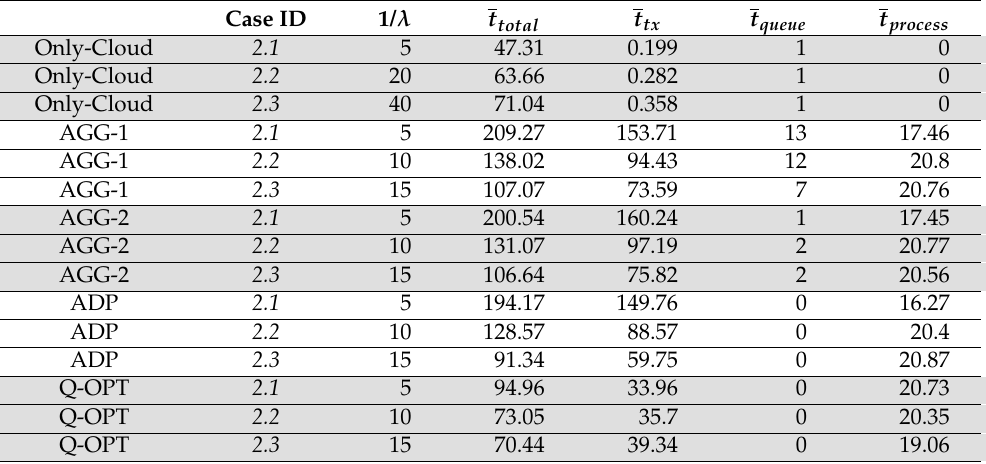
Table 7. Impact of task inter-arrival time on temporal results for task completion. Case ID 1/